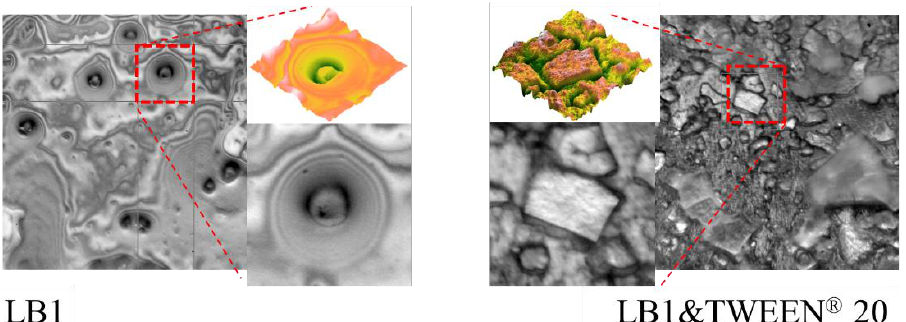
Figure 2. Images of surface structures based on superlattices of latex particles LB1 and their mixture with nonionic surfactant TWEEN ® 20 obtained in an optical microscope. The 3D images (built using the Gwyddion software environment) of the enlarged areas are shown for illustrative purposes only to more clearly emphasize the symmetry of the optical structure of the image.